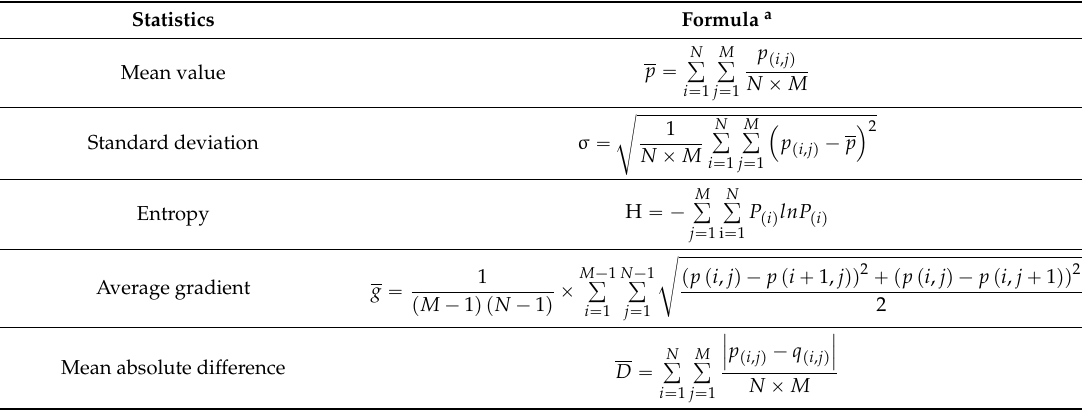
Table 3. Statistics for assessment of the quality of the synthetic